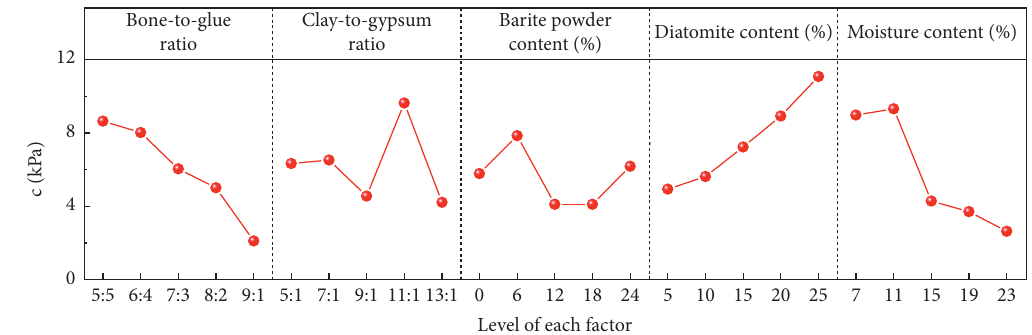
Figure 4: Intuitive analysis of cohesion